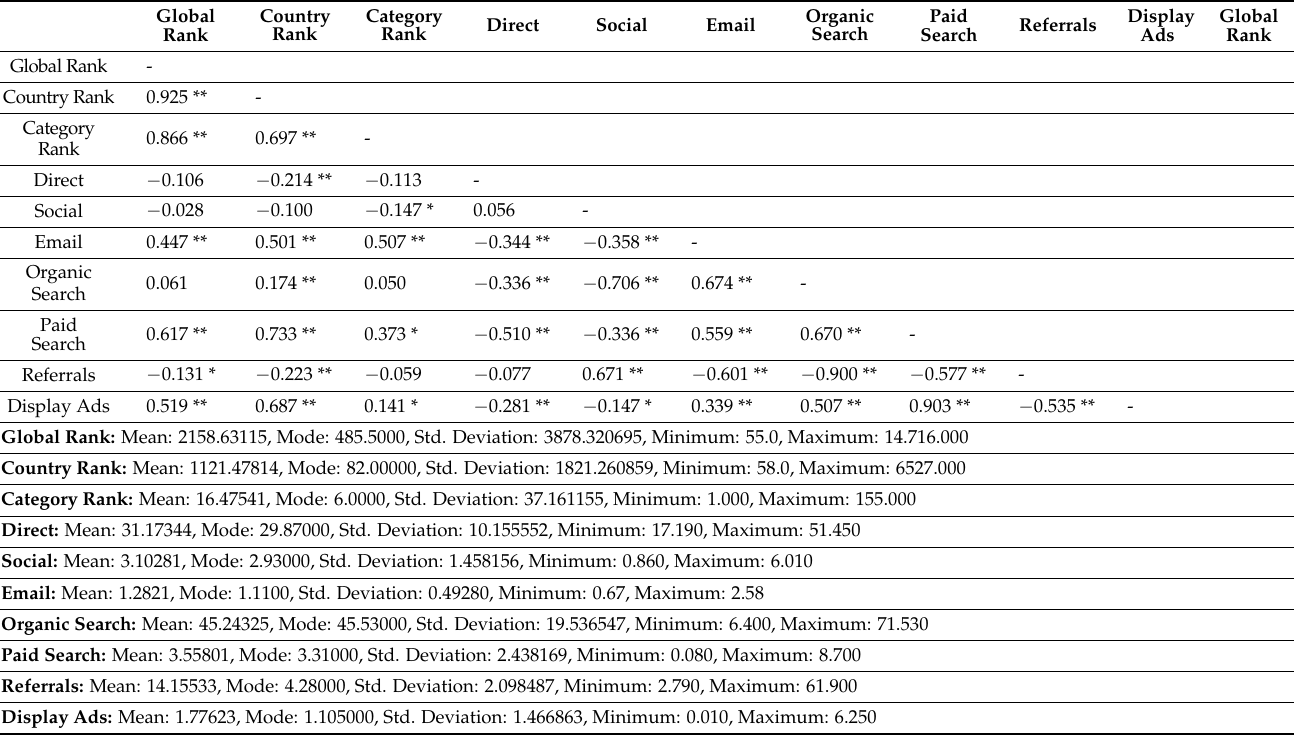
Table 2. The Pearson ρ coefficient between the web analytics metrics namely: Global Rank, Country Rank, Category Rank, Direct, Social, Email, Organic Search, Paid Search, Referrals and Display